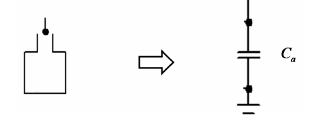
Figure 4. Cavity and hole in dynamic speaker unit. Figure 5. Cavity model and its equivalent circuit.